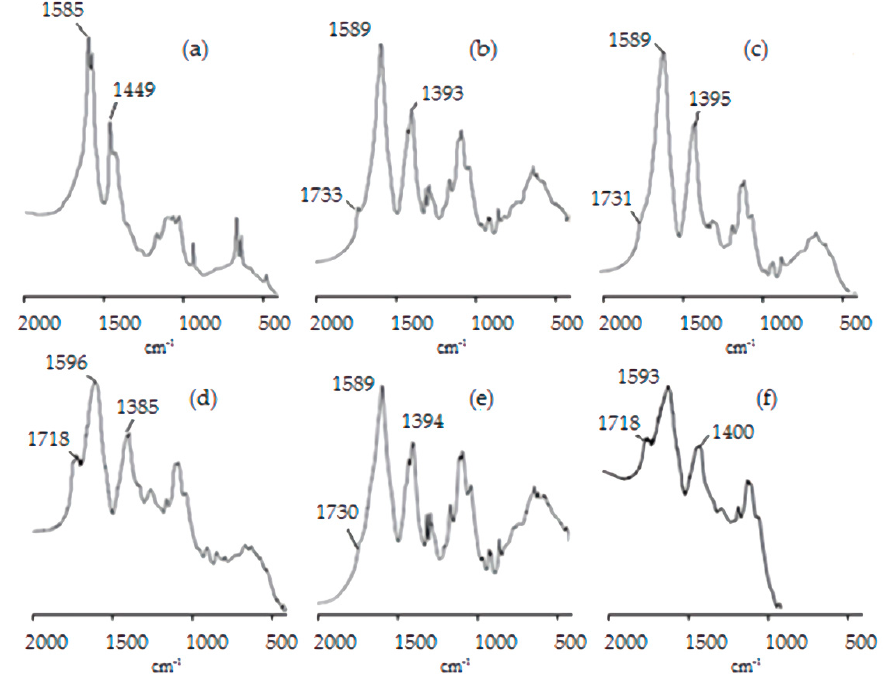
Figure 2. Fourier transform infrared spectroscopy (FT-IR) spectra of the non-cross-linked MP5700 ( a ) and cross-linked MP5708 ( b ), MP5706 ( c ), MP5704 ( d ), MP5008 ( e ), and MP4008 ( f ) chitosan microparticles.